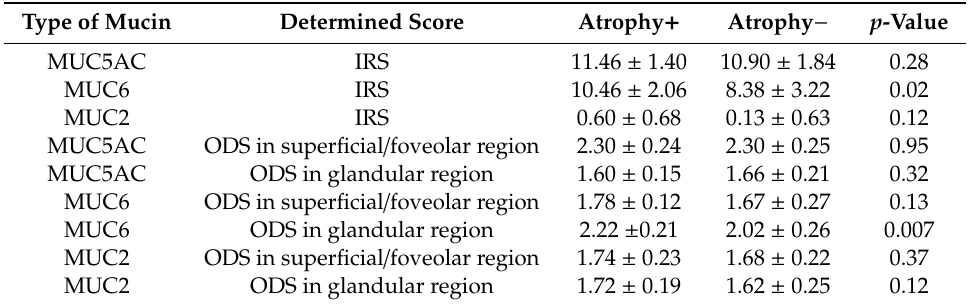
Table 3. Comparison of mucin expression in the antral mucosa between cases presenting atrophy and cases without